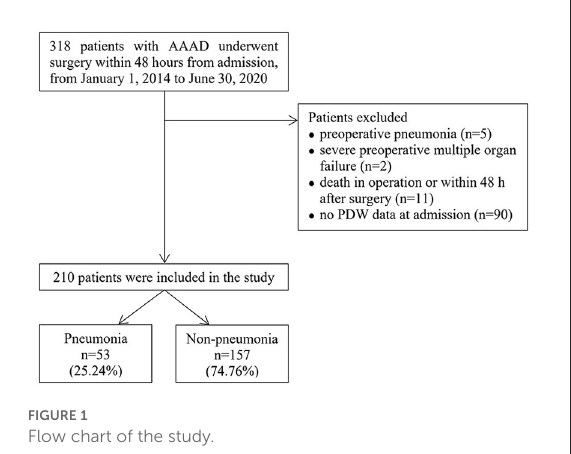
FIGURE1 Flow chart of the